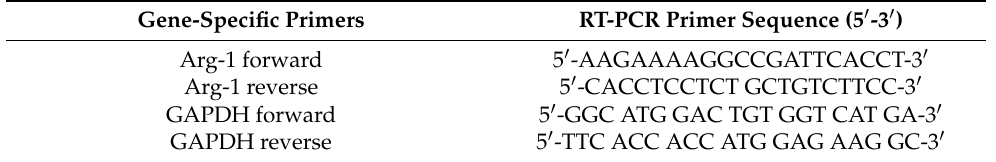
Table 1. List of RT-PCR primers used in this